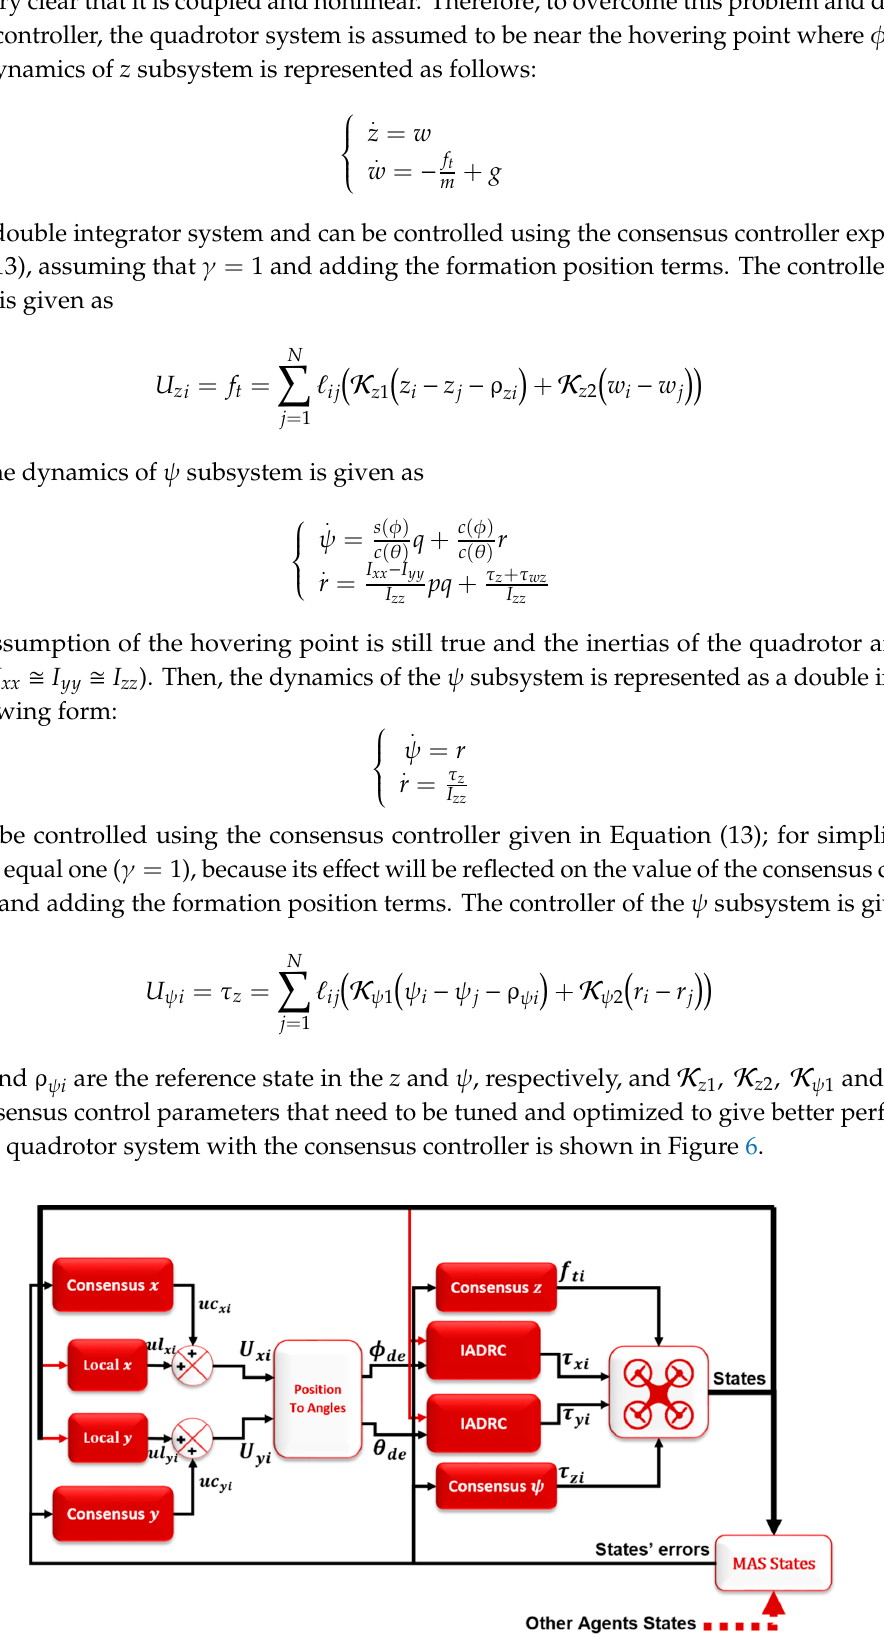
Figure 7. Three quadrotors leader–follower connection topology.